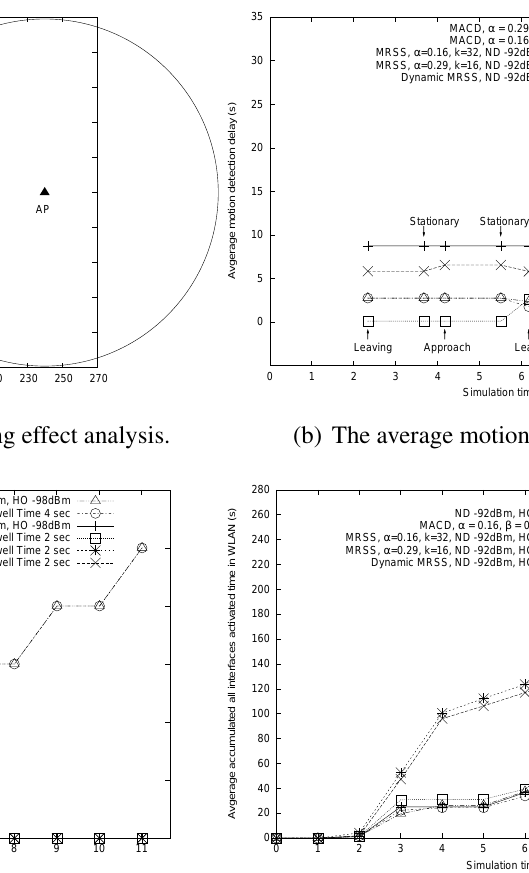
Figure 14. The performance analysis of ping-pong effect.